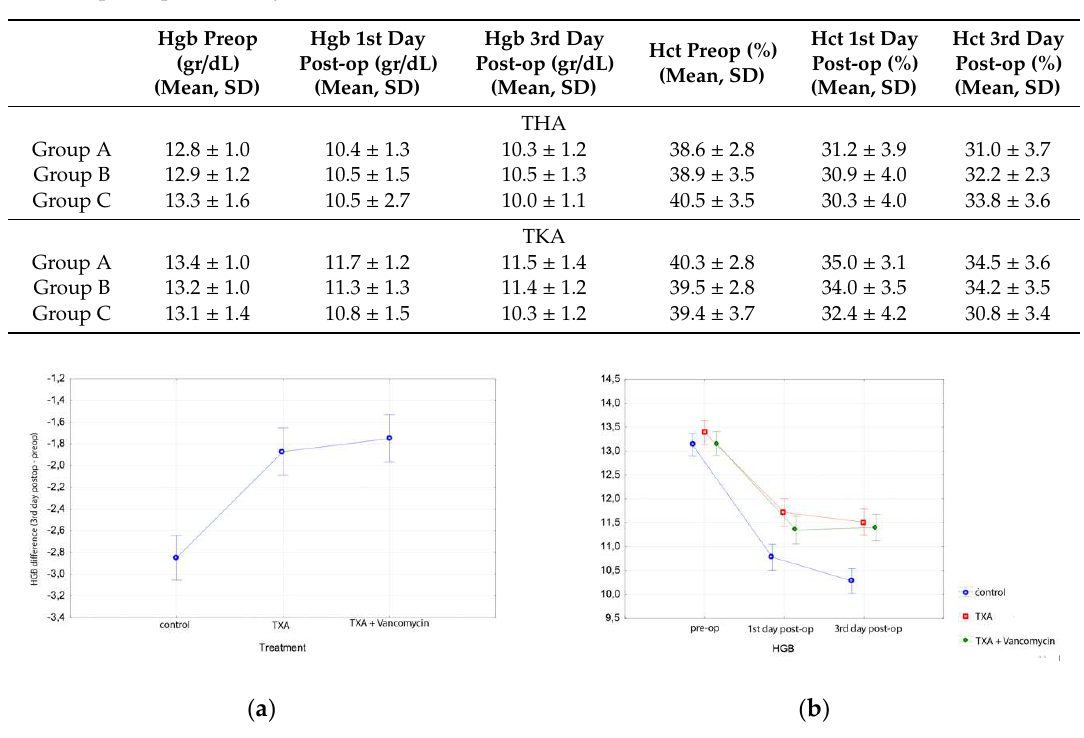
Table 2 . Hemoglobin and hematocrit values of control group (C) and treatment groups (tranexamic and tranexamic plus vancomycin) (Groups A and B) before total hip arthroplasty and during first and third post-operative day.